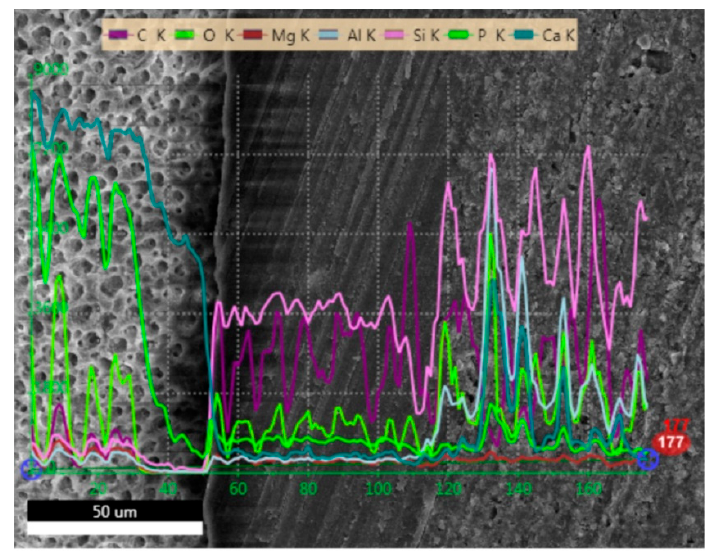
Figure 7. EDS line scan signals of individual elements present at dentin-resin interface obtained for Single Bond Universal applied in two layers.